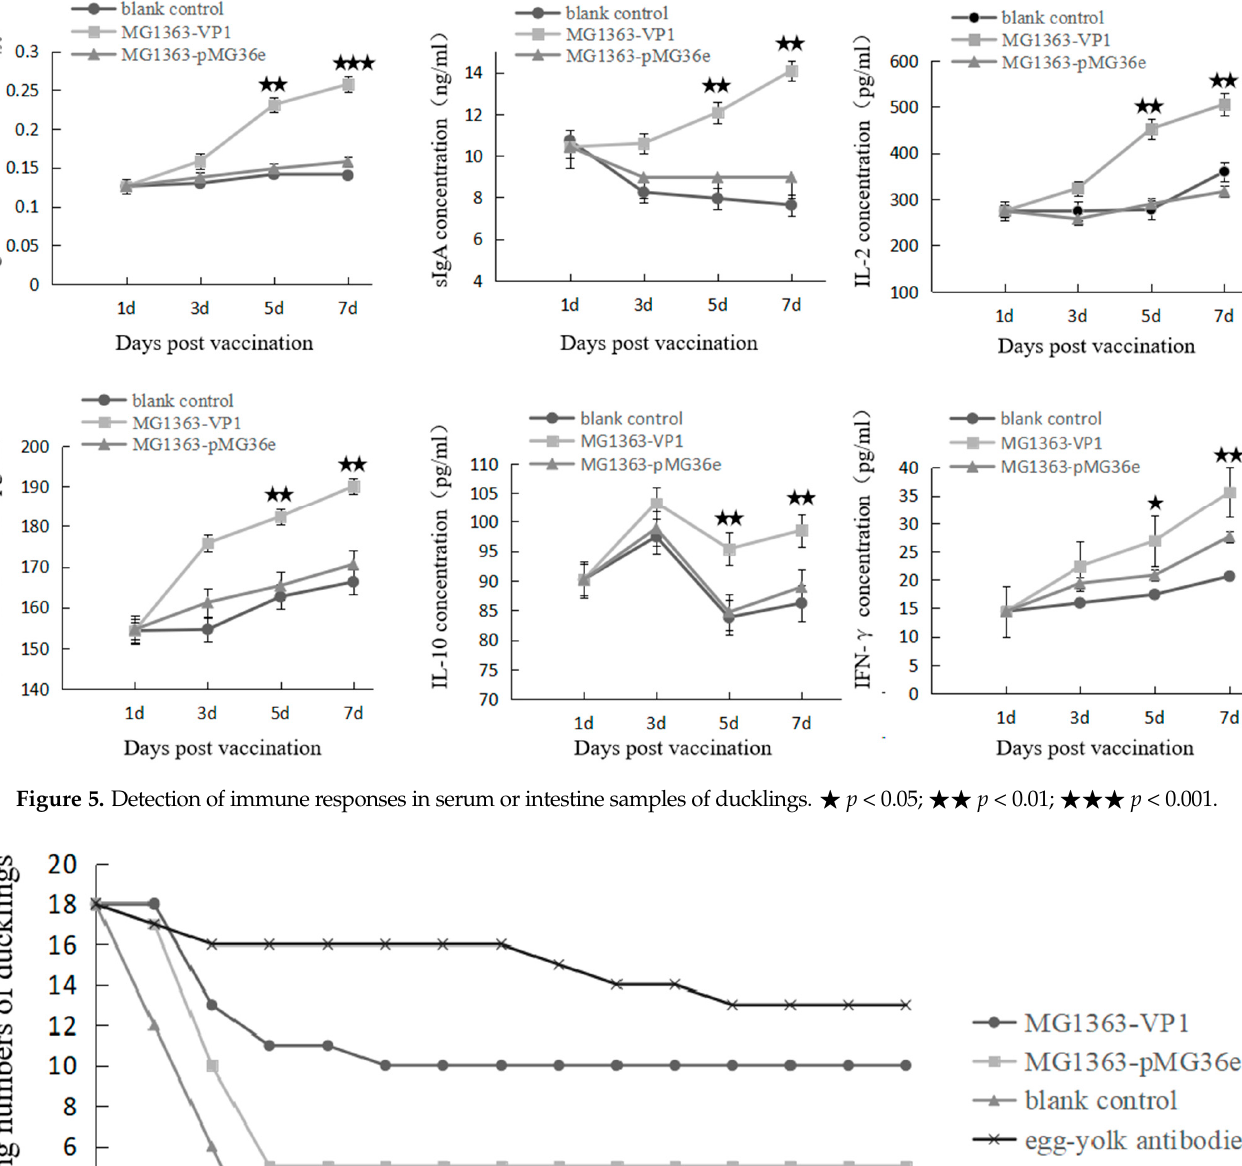
Figure 6. Surviving numbers of the ducklings after natural DHAV-1 infection.